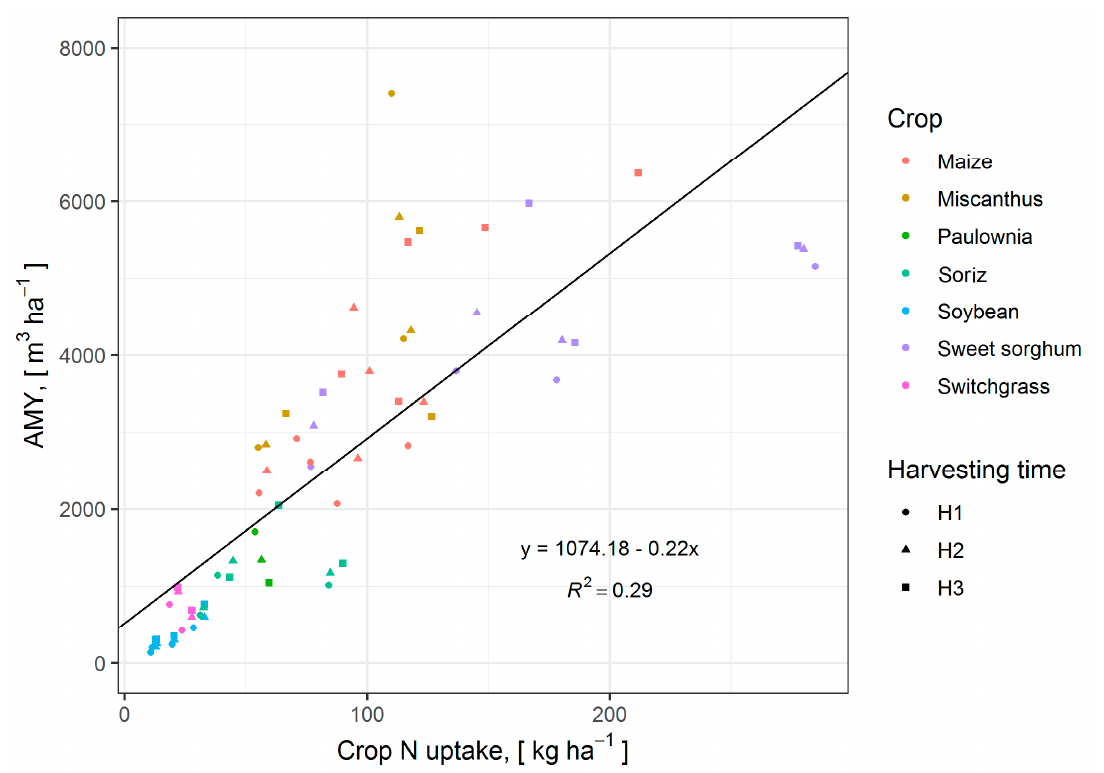
Figure 6. Correlation between crop nitrogen (N) uptake in kg ha − 1 and areal methane yield (AMY) in m 3 ha − 1 for the total of 22 varieties from 7 crops harvested in three harvesting times (H1, H2 and H3) in 2017 (total amount of samples n = 66).